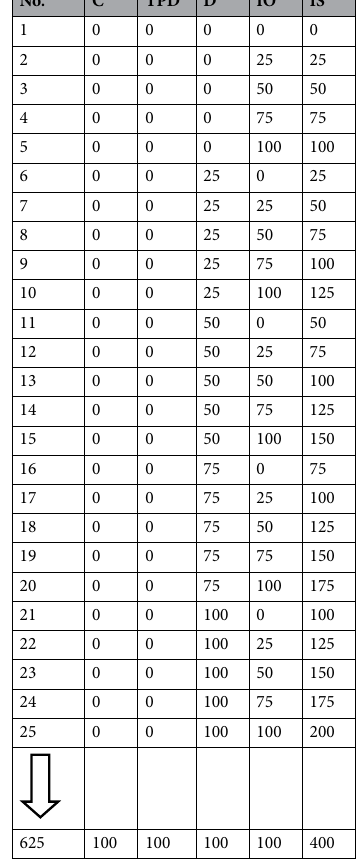
Table 1. Statical description on data set of IS